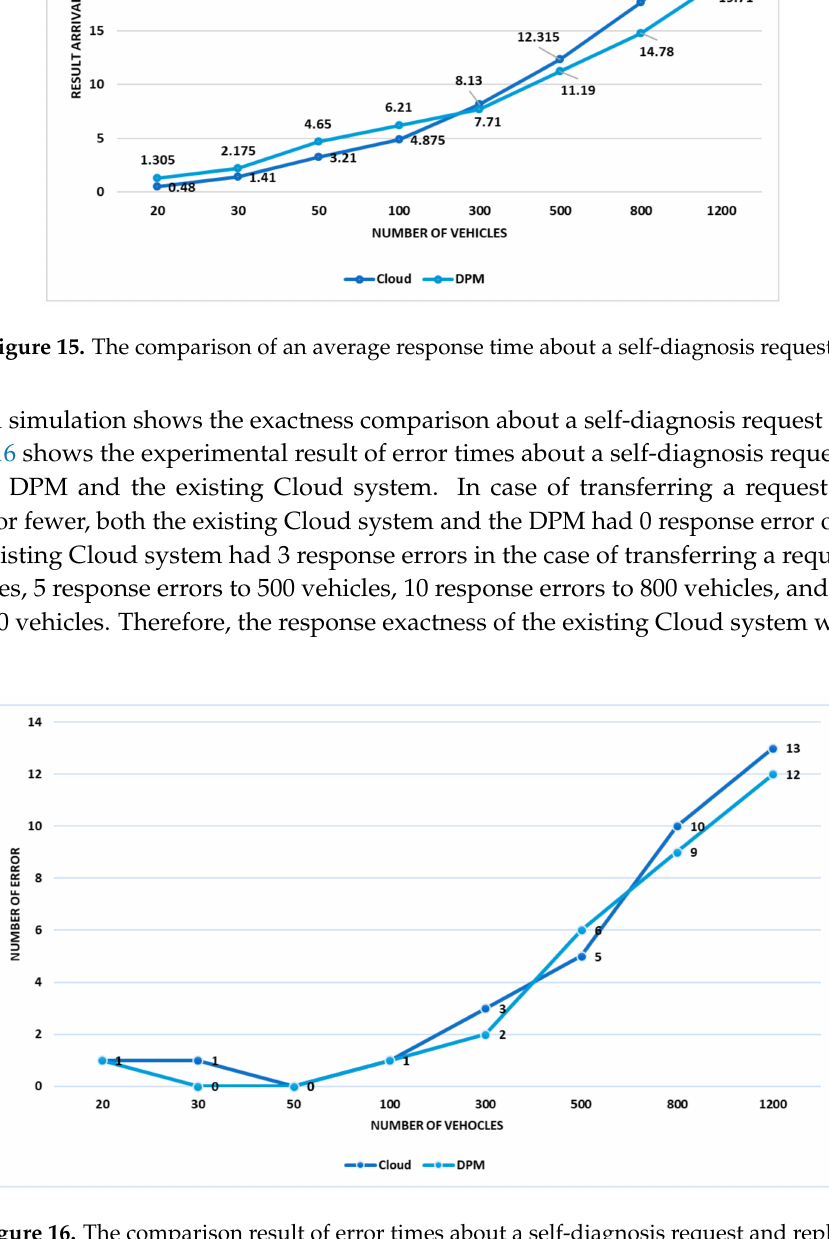
Figure 16. The comparison result of error times about a self-diagnosis request and